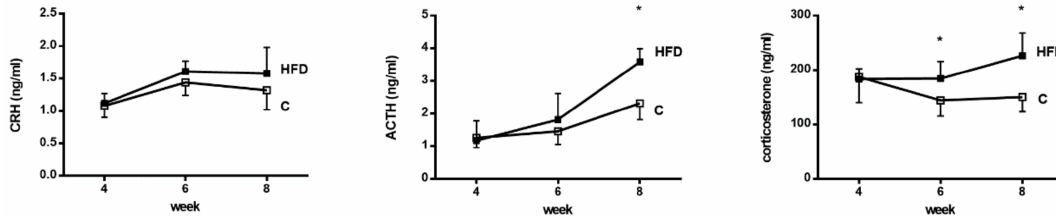
Figure 3. Influences of HFD on hypothalamus-pituitary-adrenal (HPA) axis in NAFLD rats. Plasma ACTH and corticosterone levels increased along with the time in HFD group. Nevertheless, corticotropin-releasing hormone (CRH) level was not significantly a ff ected. (* p <